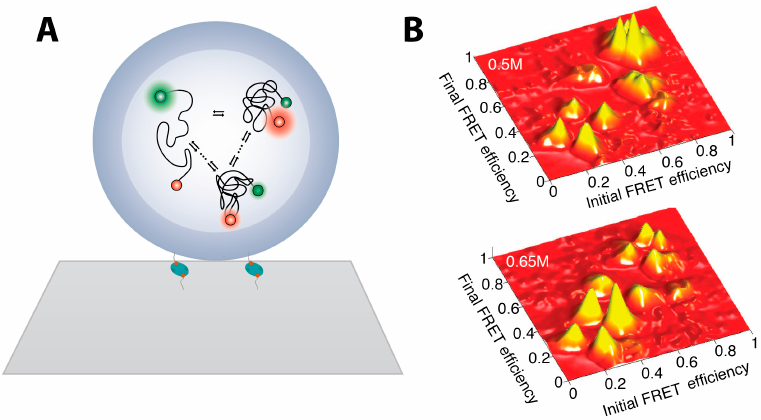
Figure 2. smFRET studies of adenylate kinase enzymes folding ( A ) Individual AK enzymes, double labeled for smFRET measurements, were encapsulated inside liposomes minimizing interaction with hard matter allowing unbiased measurements of the folding landscape. Liposomes are tethered on glass microscope surface via biotin-avidin interaction; ( B ) Transition density plots showing the preferred transition pathway of folding to depend on denaturant concentrations. As the denaturant concentration increases more transition between lower FRET states occur and the fraction of sequential—between states of similar FRET intensity—increases (Figure 2 is adapted from [74] with